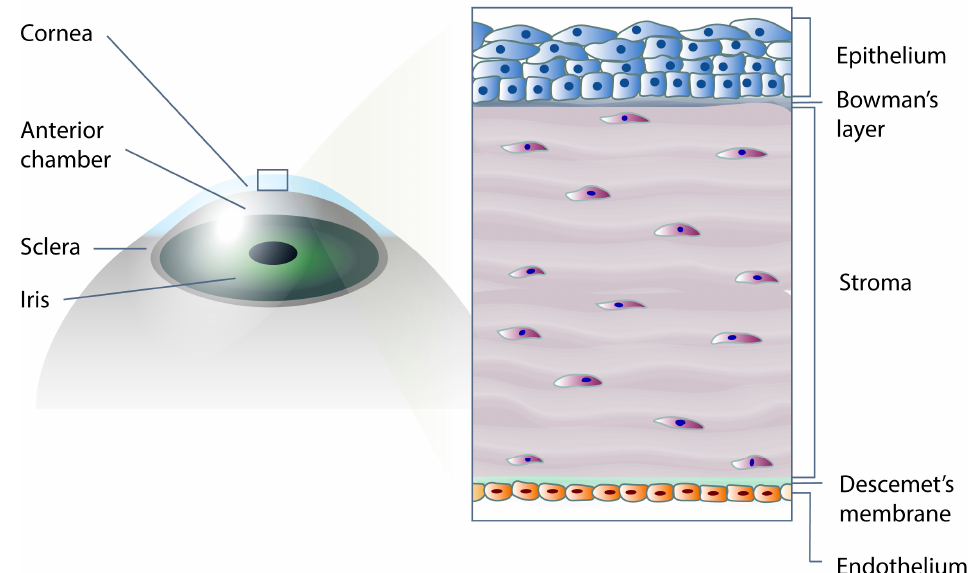
Figure 1. Anatomy of the cornea with schematic representation of its five main layers. Epithelial cells are indicated in blue, stromal keratocytes in purple and endothelial cells in orange.